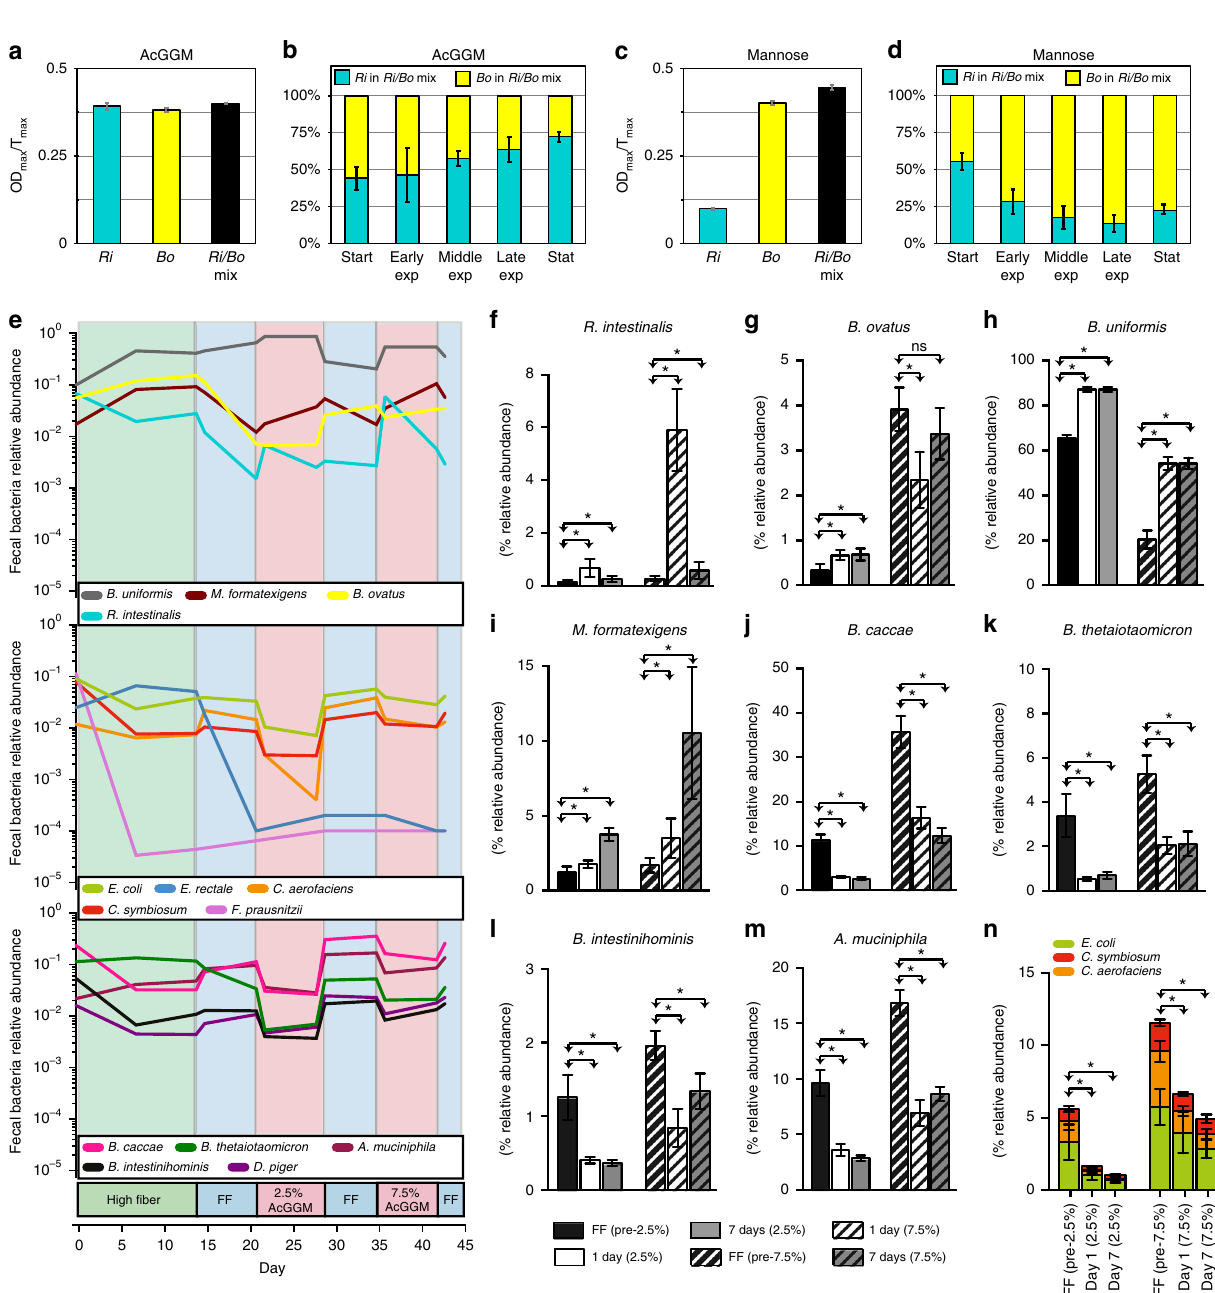
Fig. 6 R. intestinalis and B. ovatus co-culture experiments and in vivo modulation of a synthetic human gut microbiota via AcGGM. a , c Growth rates of mono- and mixed cultures of R. intestinalis L1 – 82 ( Ri ) and B. ovatus ATCC 8483 ( Bo ) on either AcGGM or mannose. Growth rate is de fi ned as the maximum increase in absorbance at 600 nm (OD max ) divided by the time (T max , in hours) to reach the maximum growth. b , d In vitro competition experiment with R. intestinalis L1 – 82 and B . ovatus ATCC 8483 on either AcGGM or mannose as sole carbon source. The pH of the stationary phase cultures after growth on either AcGGM or mannose was 5.8 ± 0.16 and 5.6 ± 0.11 (two biological triplicates, ± indicates the s.d.), respectively, thus showing that the results are not due to differences in acid sensitivity between the two strains. The relative abundance of the bacteria for each different phases of growth was determined by quantitative PCR of species-speci fi c vs universal primers targeting the 16 S rRNA genes. In a – d , the histogram bars show the mean of two biological replicates, with three independent measurements per replicate. Error bars represent s.d. Abbreviations: Early exp, early exponential phase; Middle Exp; middle exponential phase; Late exp, late exponential phase; Stat, stationary phase. e Relative abundance of bacteria in fecal samples from germfree mice colonized with a synthetic human microbiota. Mice were shifted from a fi ber-free (FF) diet to varying amounts (2.5% and 7.5% w/w) of AcGGM over time. Data are average of seven mice. f – i Relative abundance of individual β -mannan-degrading bacteria and j – m mucus-degraders. n Additive relative abundances of three amino acids degraders. In f – n histogram bars show the average of seven biological replicates while error bars represent s.d. P -values were calculated by two-tailed Student ’ s t test. An asterisk (*) indicate a statistically signi fi cant difference ( P < 0.05) in the relative abundance of each bacterium compared to that of the speci fi c pre-FF diet. ns, not signi fi cant ( P ≥